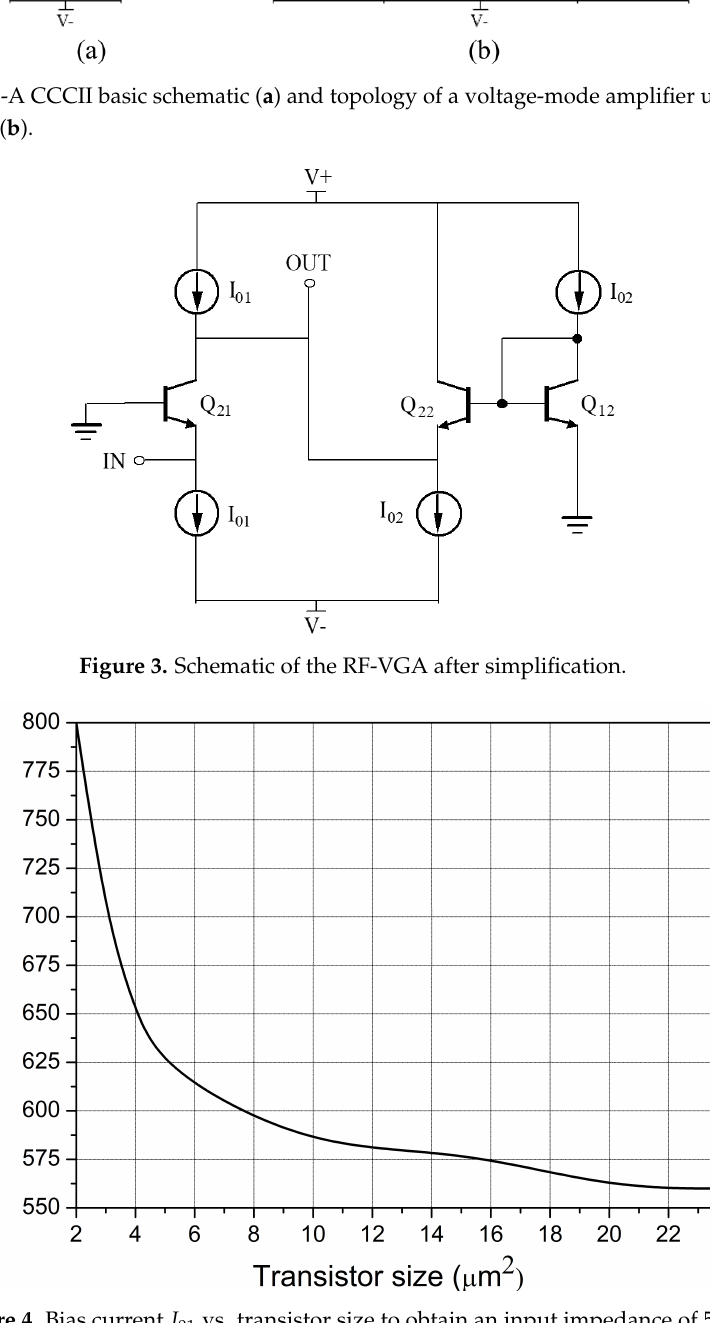
Figure 4. Bias current I 01 vs. transistor size to obtain an input impedance of 50 Ω